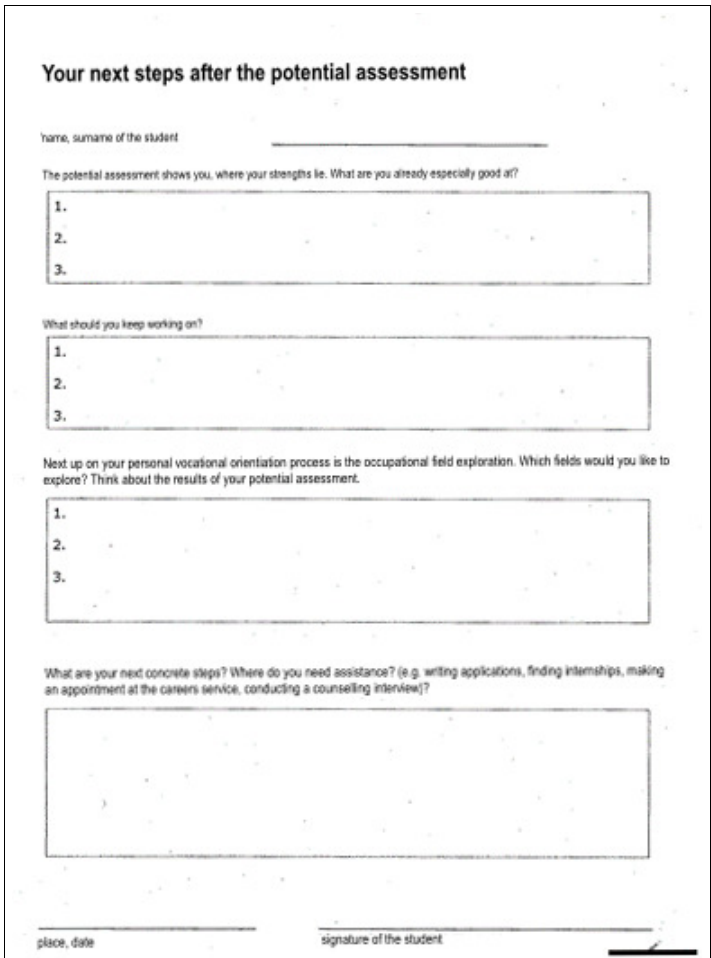
Figure 3. Next steps after the competency